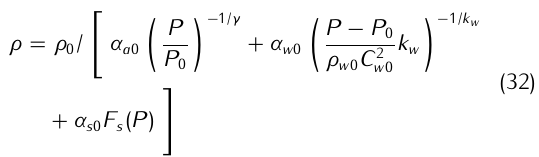
Figure 5. Sandy gravel with 0.9% average moisture content. In a) pressure versus density, measurement data is shown together with a polynomial function (based on the mea- sured compaction) and fully compacted line. In b) the corresponding tabular data.